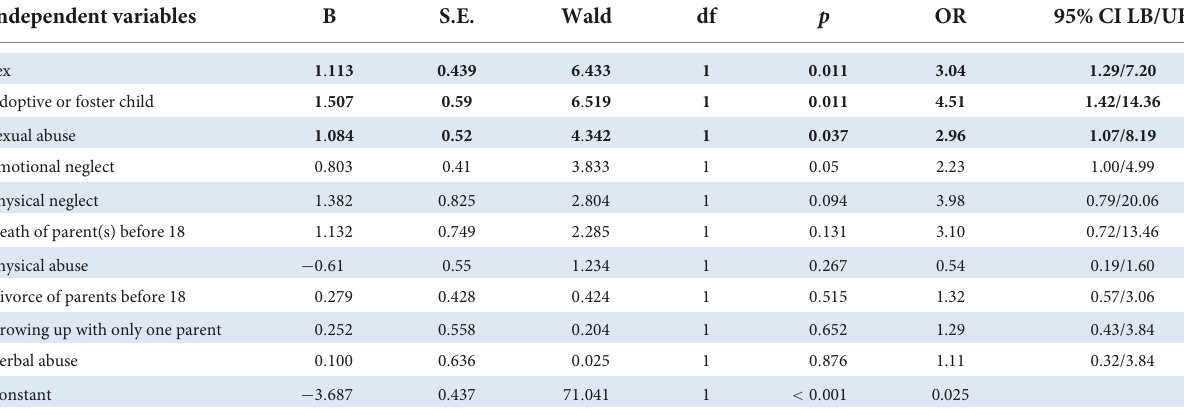
TABLE 3 Logistic regression model for recorded adverse childhood experiences and the co-variable sex as predictor for a former child and adolescent inpatient treatment in young psychiatric inpatients. Independent variables B